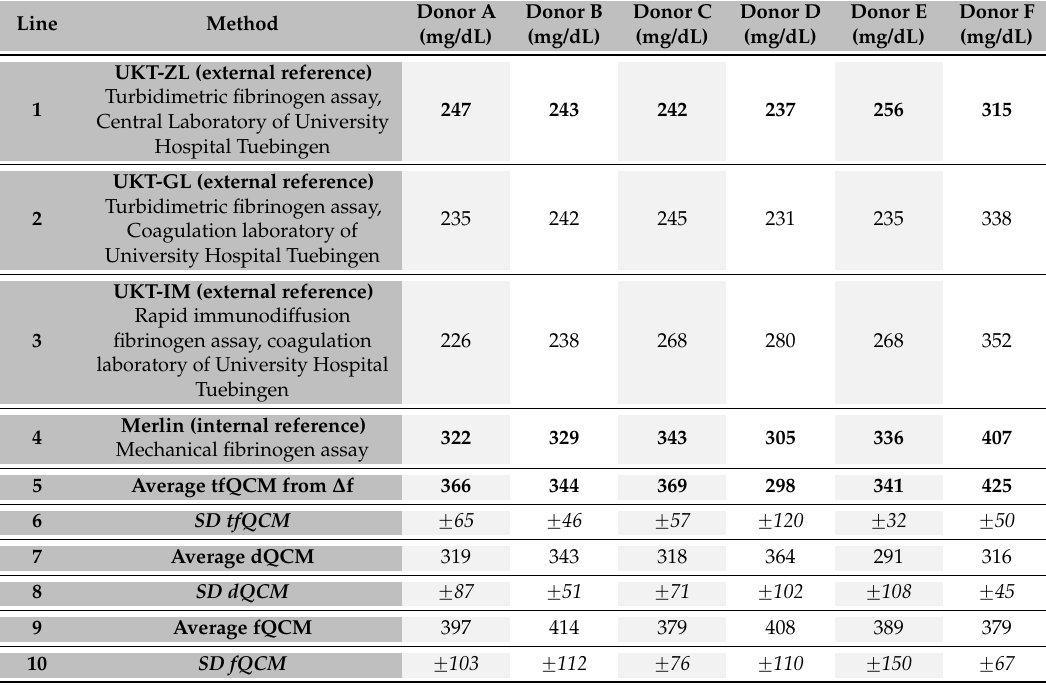
Table 1. Numeric overview of the fibrinogen results of donor A–F based on the mean values of the QCM-D method, the internal reference (Merlin coagulometer) and the standard laboratory testing of three different standardized external references (UKT-ZL, UKT-GL, UKT-IM). The QCM-D-based numeric results are the calculated mean values of the measurements presented in Figure 4. The standard deviation (SD) between the QCM-D measurements is